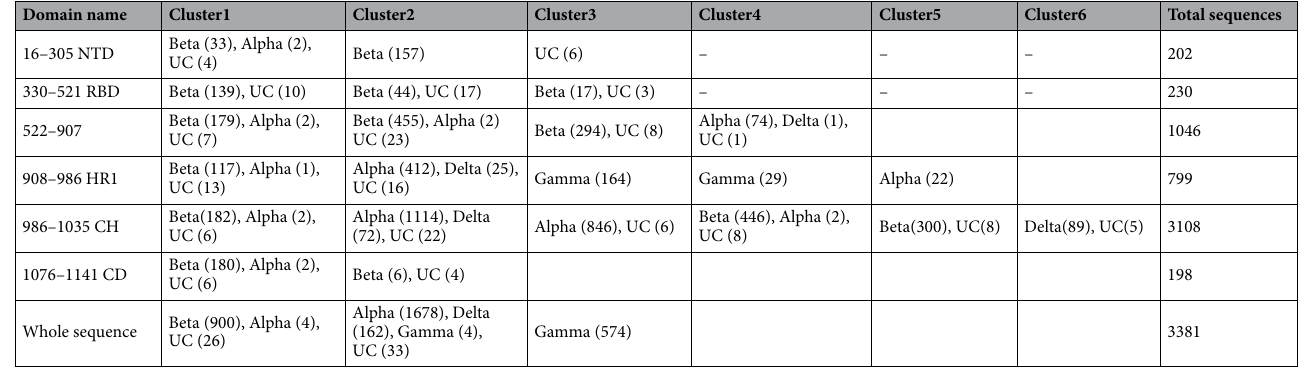
Table 1. Details of clustered sequences.